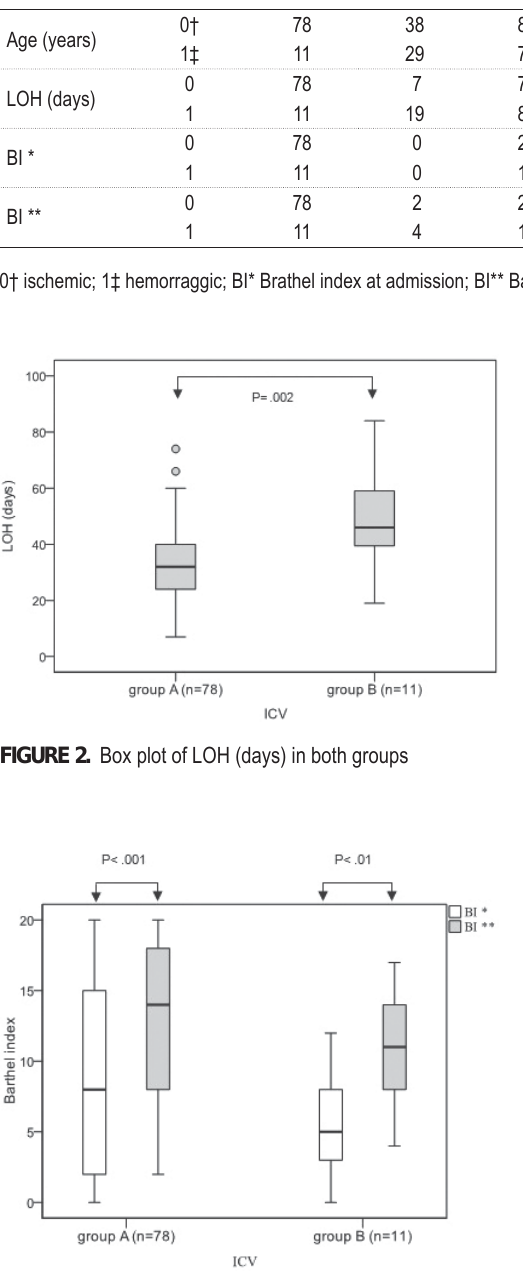
FIGURE 3. Box plot of Barthel index at admission and dis- charge in both groups (BI* Brathel index at admission; BI** Barthel index at discharge)